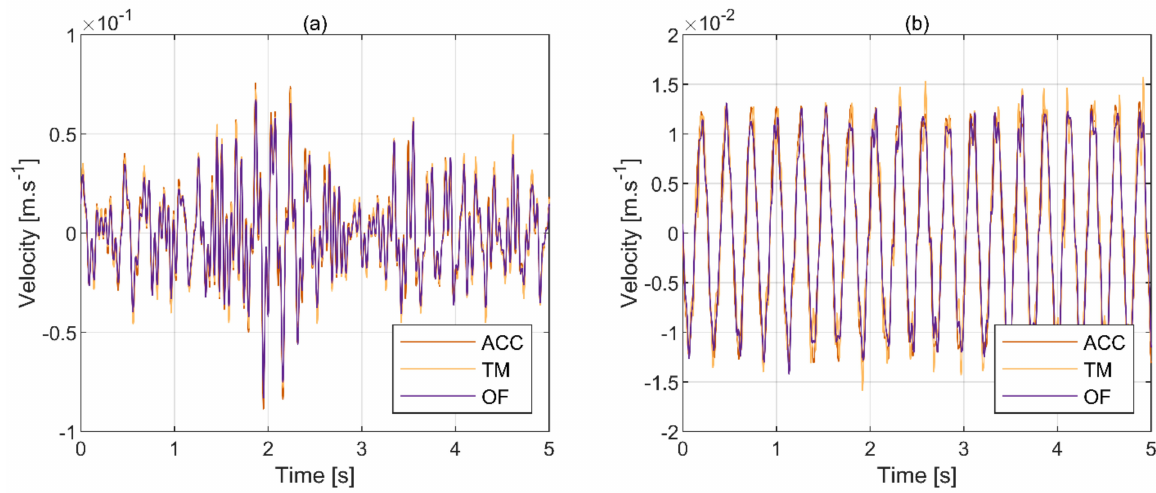
Figure 6. Truncated time-aligned response signals recorded at the excitation point during ( a ) T2 and ( b )